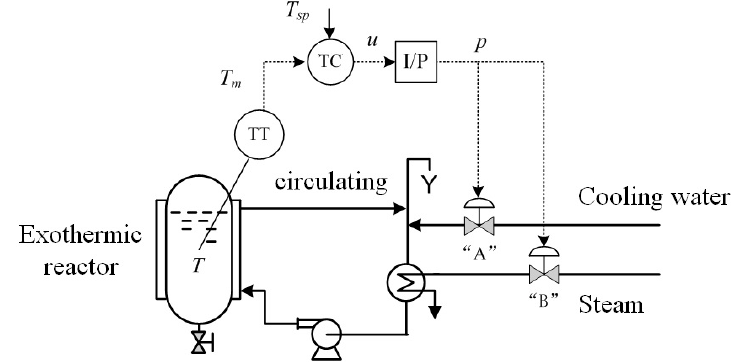
Figure 4. The control schematic of the exothermic reactor working at the P3